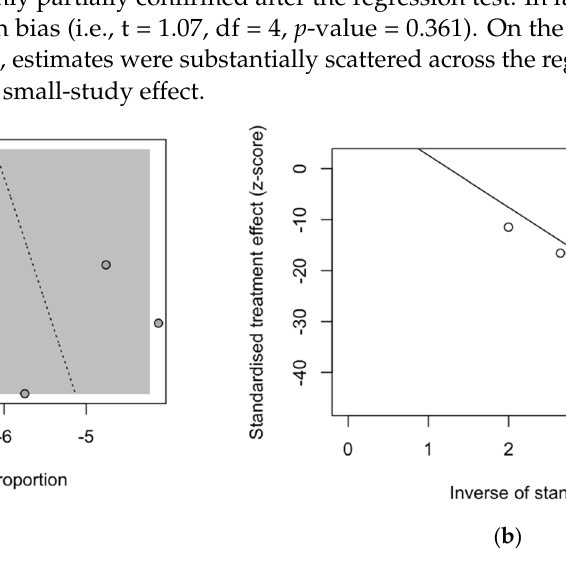
Figure 4. Funnel plots for studies included in the meta-analysis ( a ). Despite the reduced number of included studies, visual inspection suggested substantial evidence of publication bias for both subgroups, but this was substantially rejected by Egger test (1.07, df = 4, p -value = 0.361). On the other hand, in radial plots ( b ), the studies were substantially scattered across the regression line, suggesting no substantial small-study effect.